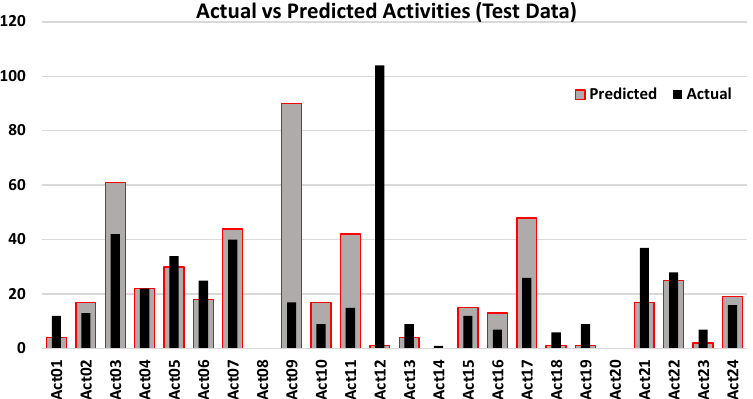
Figure 6. Prediction vs Actual activities in the test